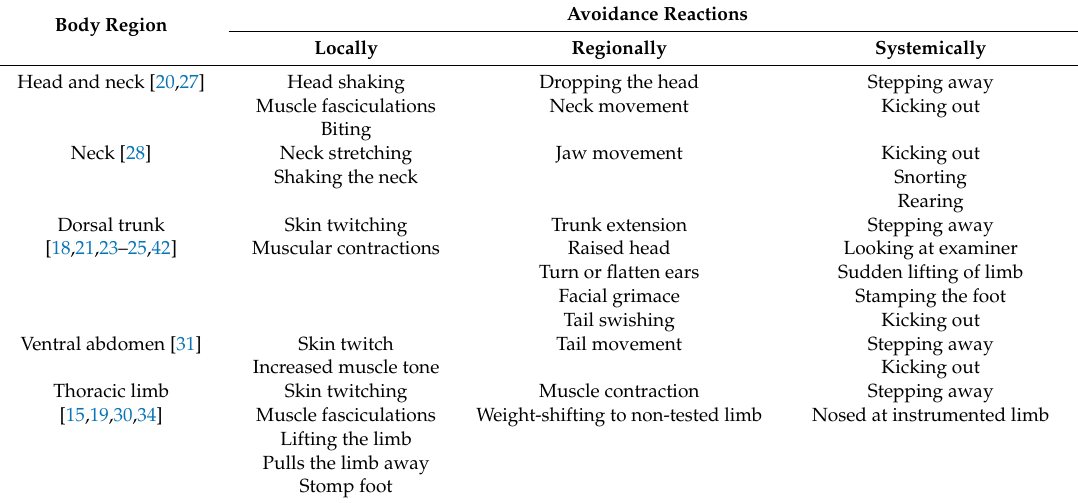
Table 7. Avoidance reactions to pressure algometry applied across body regions. Avoidance Reactions Body Region Locally Regionally Systemically Head and neck